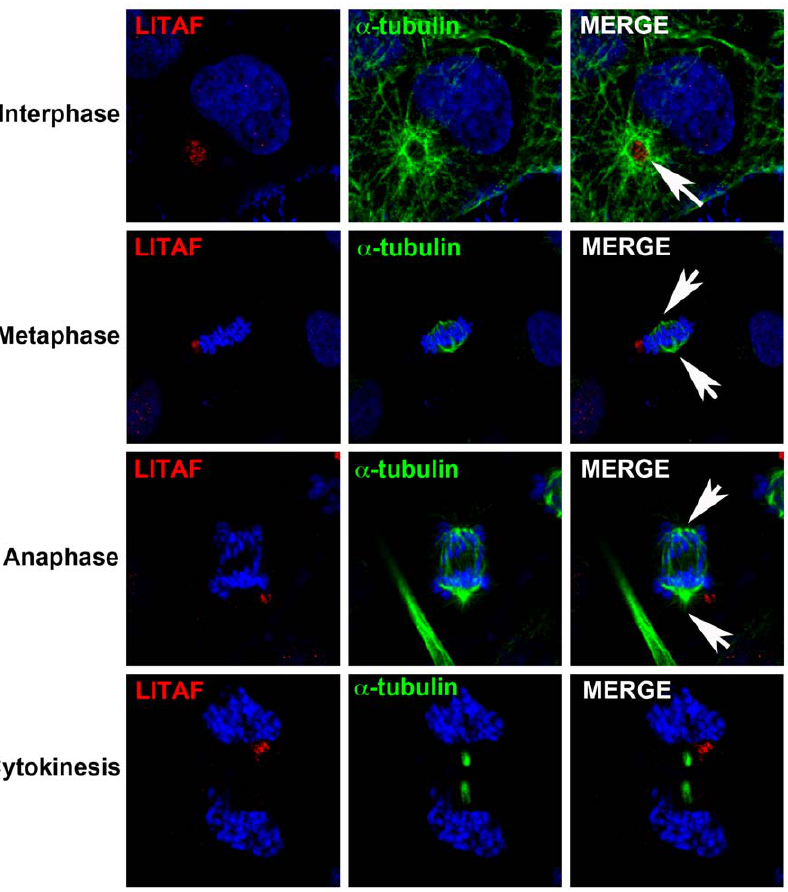
Figure 2. Endogenous LITAF undergoes asymmetric inheritance. In order to determine whether LITAF localized to centrosomes or aggresomes, BGMK cells were fixed and processed for indirect immunofluorescence. Cells were probed for endogenous LITAF (anti-LITAF antibodies; red), anti- a -tubulin (green), and ToPRO (Invitrogen; blue) were used to visualize the mitotic stage of each cell during interphase or mitosis. White arrows denote the sites of microtubule nucleation (MTOC).